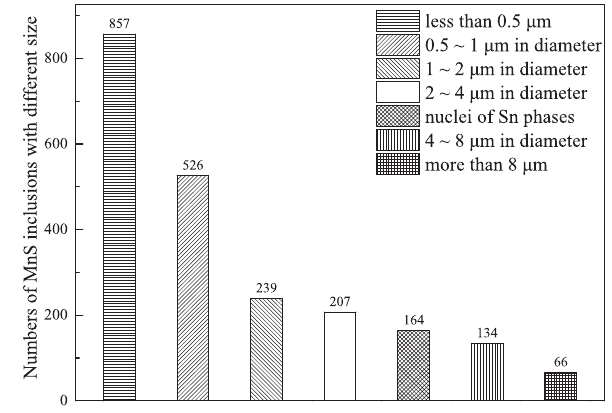
Fig. 2: The statistical results of MnS